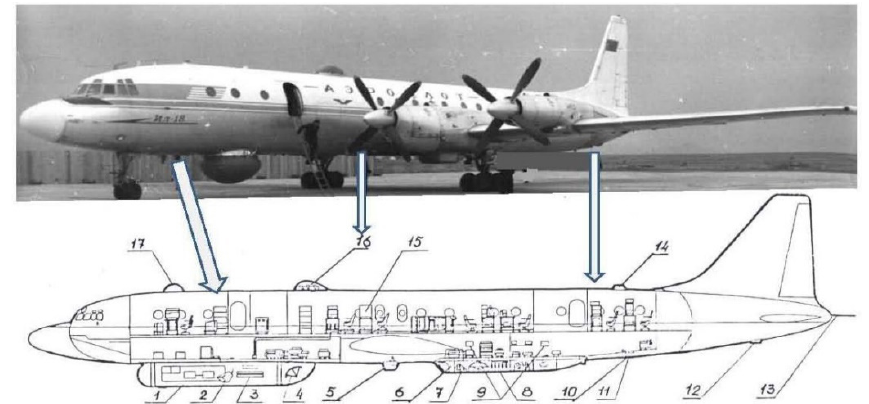
Figure 1. Main layout of the remote sensing systems on-board the IL-18 flying laboratory (hull No 75423). Note: 1,3—synthetic aperture detectors, wavelengths of 2.0 and 10.0 cm; 2,6—trace polarimeters, wavelengths of 0.8 and 2.25 cm; 4—six-channel scanning polarimeter, wavelengths are 0.8, 1.35, 2.25, 5.5, 10, 21 and 27 cm; 7,9—altimeter and interferometer, wavelength is 2.2 cm; 13—sub-surface sensing station of decimetric range; 5,10,12—large-format and frame TV, aerocamera; 11,14—radiometers of mm range; 16—radiometers traces, L- band; 15—gravimetric and inertial devices; 17— astro-hatch.